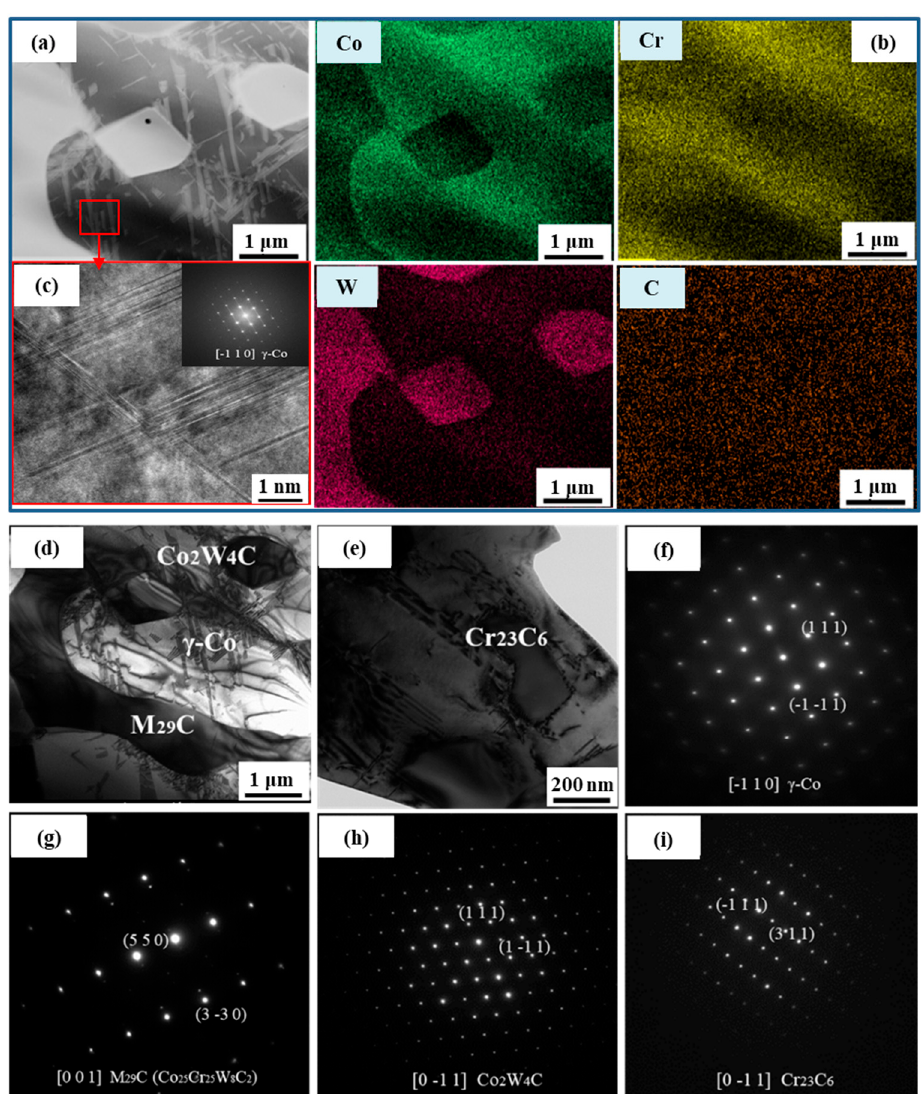
Figure 7. (a) TEM bright-field image of the Co–Cr–W alloy; ( b – d ) Selected area electron diffraction (SAED) patterns of γ -Co ( b ), M 29 C ( c ), and M 6 C ( d ); ( e ) and EDS maps performed on a micro-area.